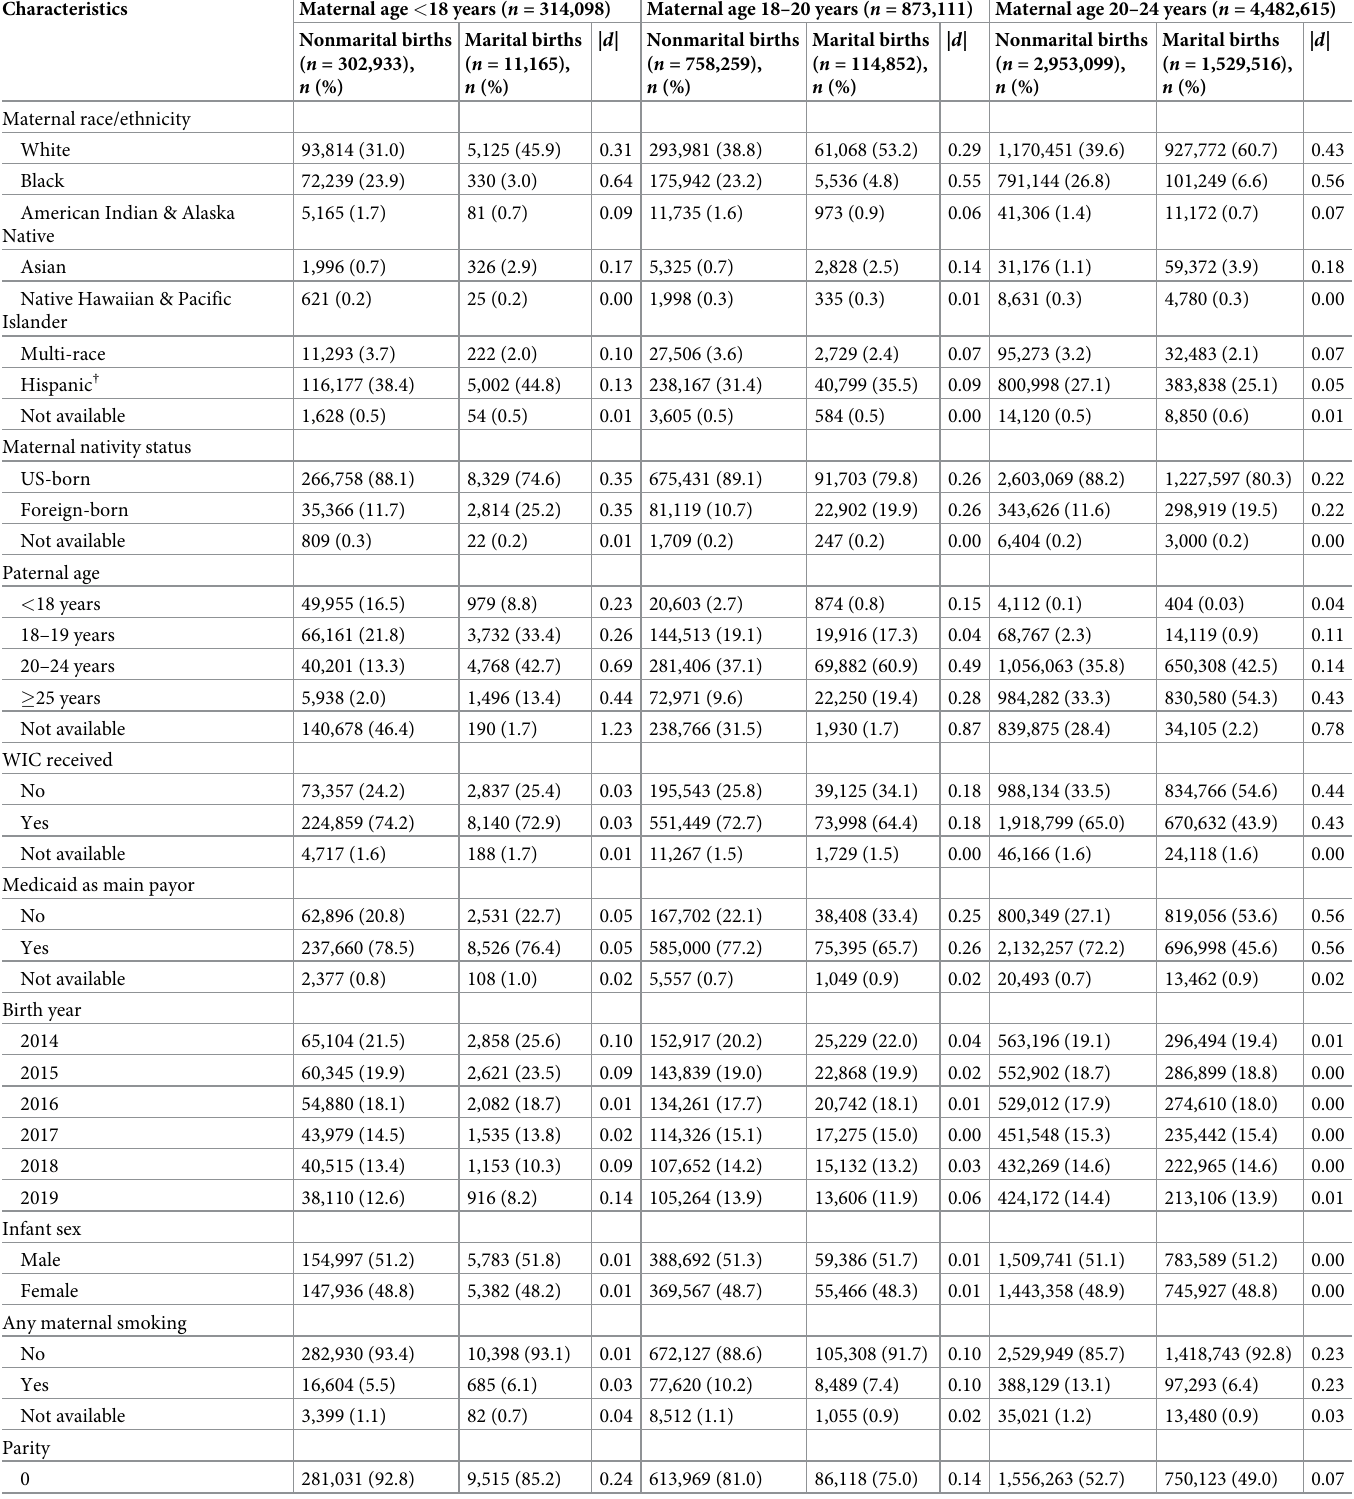
Table 2. Characteristics of births to US mothers aged � 24 years by maternal age group and marital status, 2014–2019 ( n = 5,669,824) � AU : ForTable 2 ; therewasanasteriskfootnotebutnoasterisksymbolinthetable : Iaddedanasterisktothetitle : Ifthisisnotthecorrectplacementforthisfootnotesymbol ; pleaseeditasnecessary : .